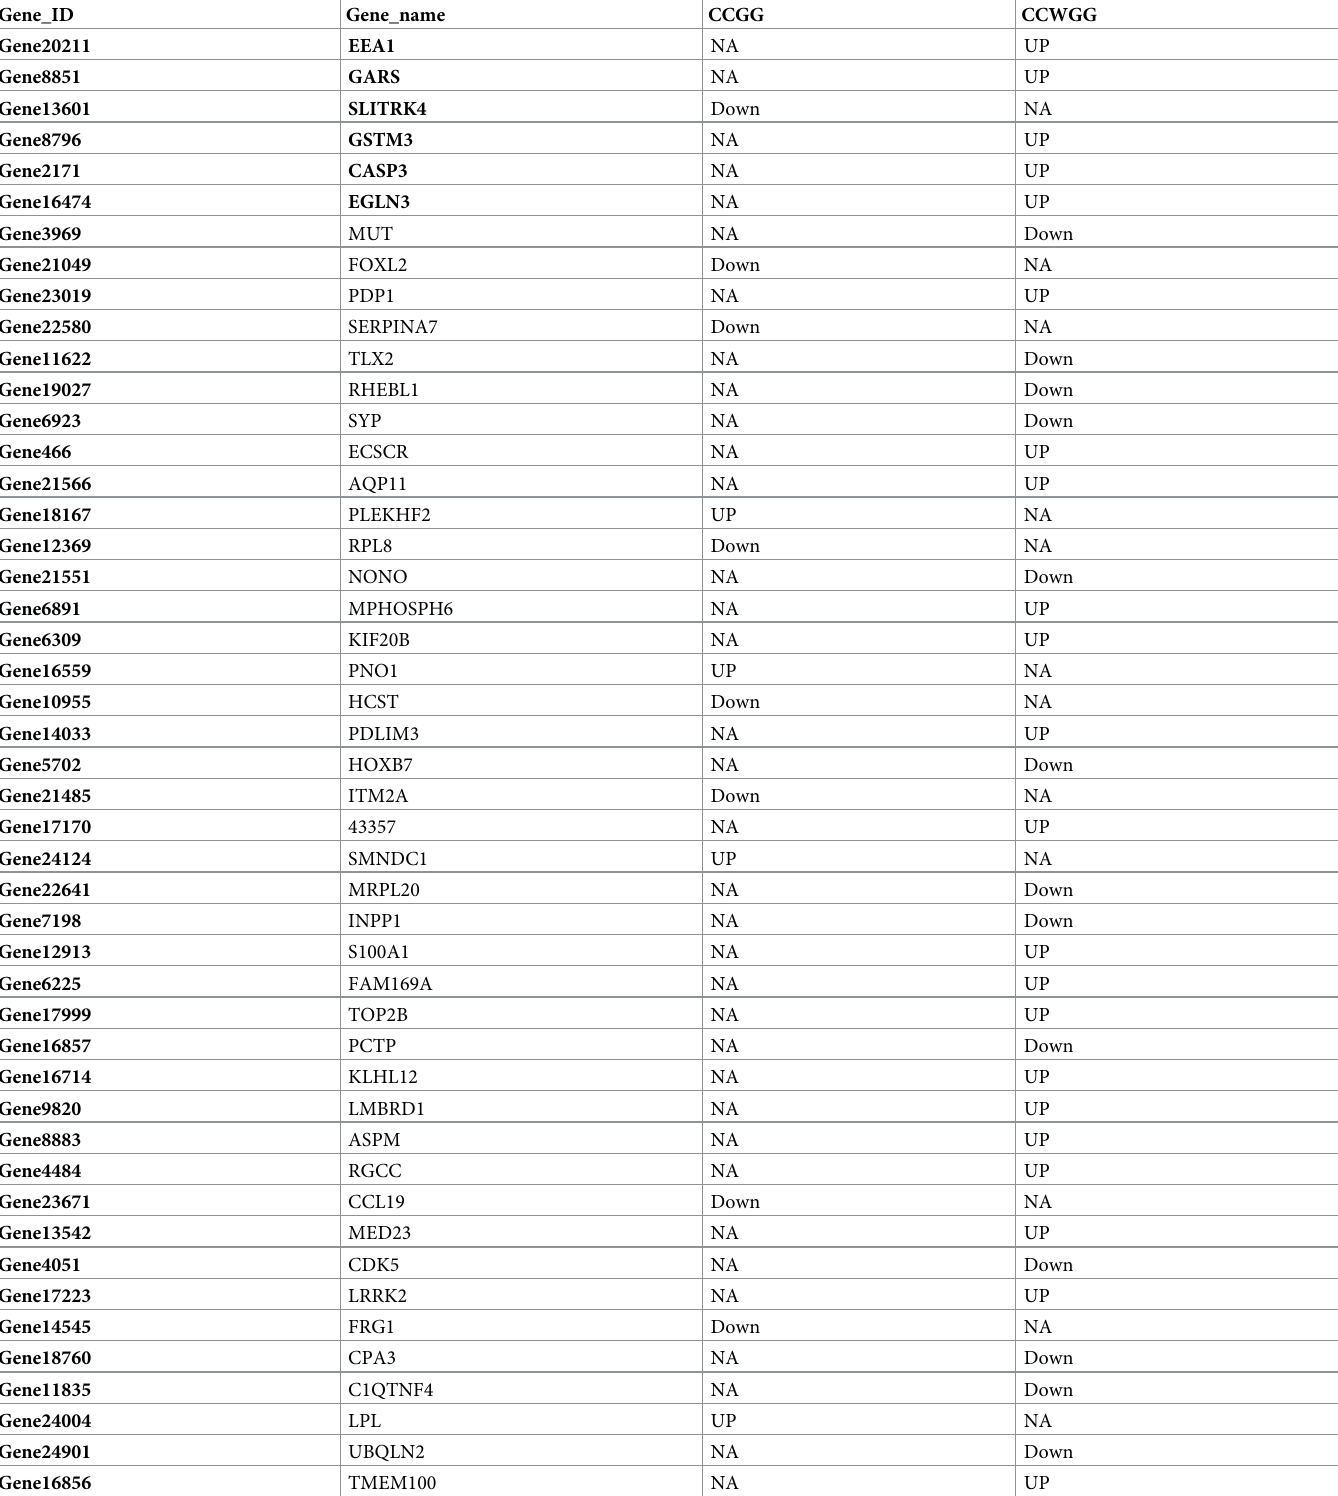
Table 6. Candidate